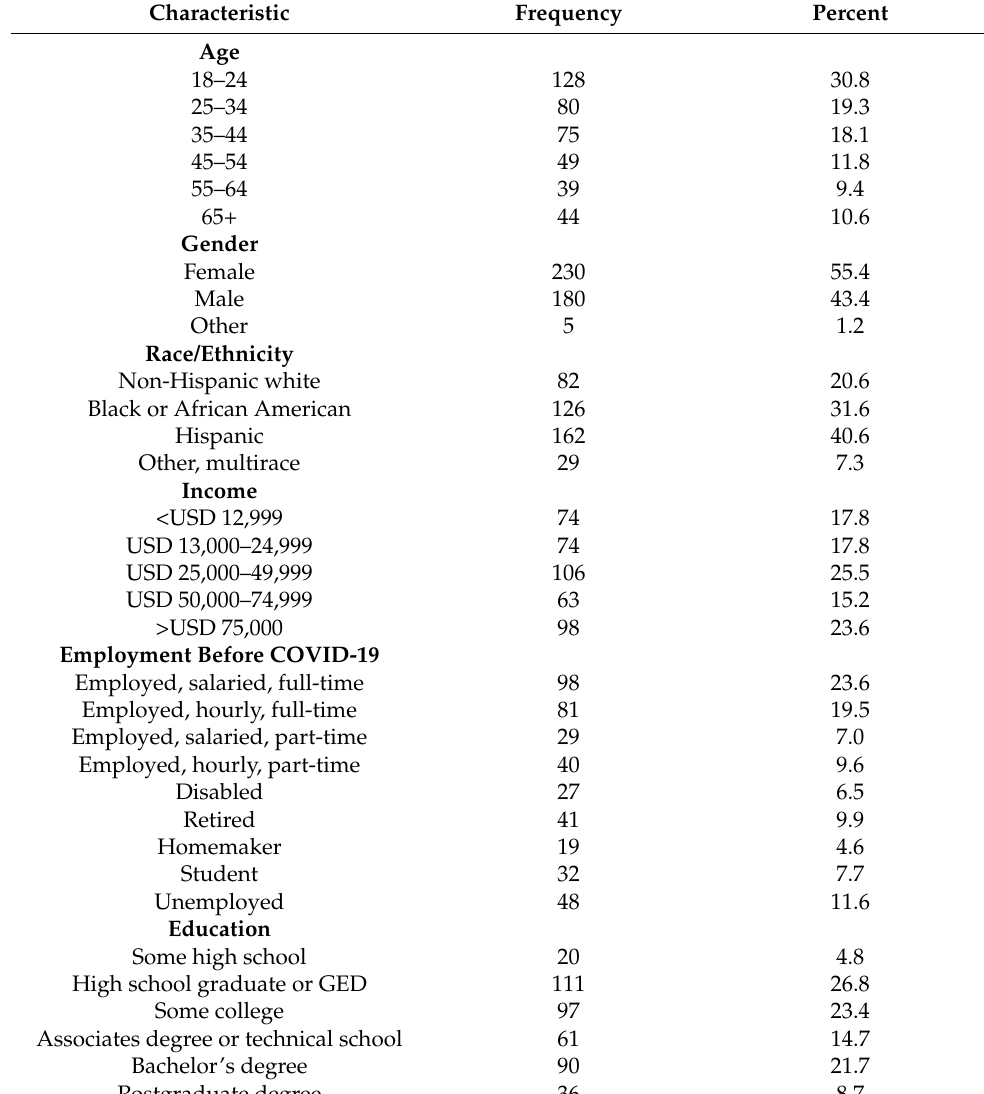
Table 2. Demographic characteristics of the